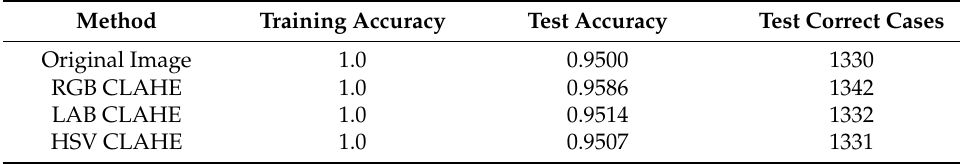
Table 6. Effects of color spaces on RSSCN7